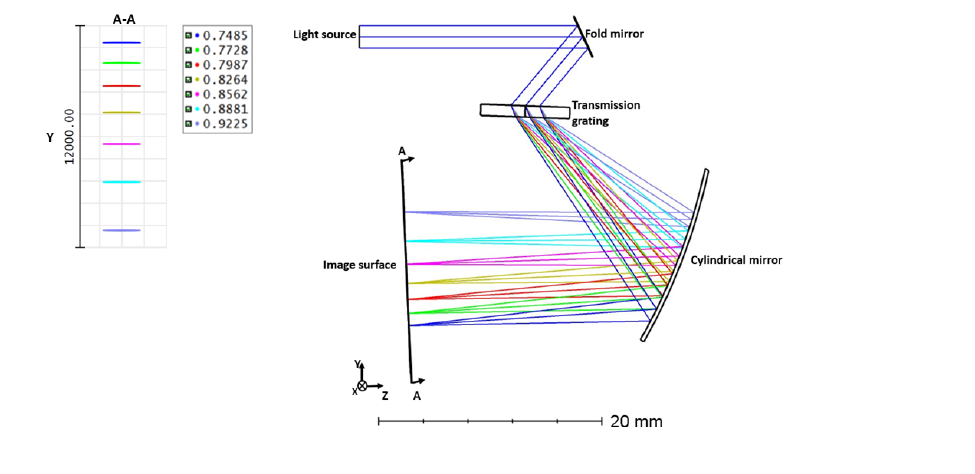
Figure 4. Design of the spectrometer with transmission grating in ZEMAX and dispersed spectrum on the image